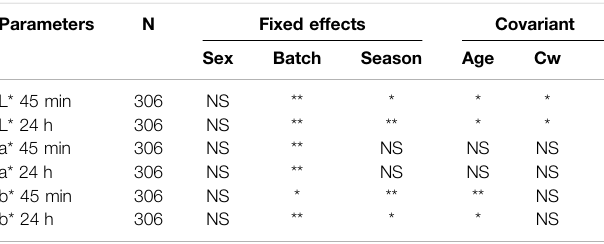
TABLE1| Signi fi canceofthe fi xedeffectsandcovariantinthemixedmodelforthe analysis. Parameters